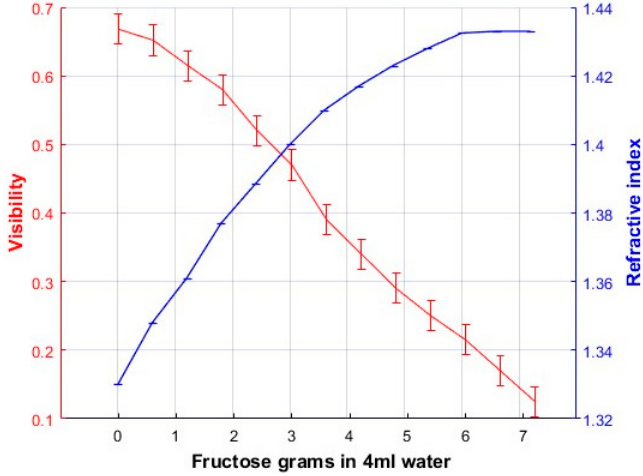
Figure 6. Calibration plot when solutions of fructose-water were considered. Sensors 2017 , 17 , 2844